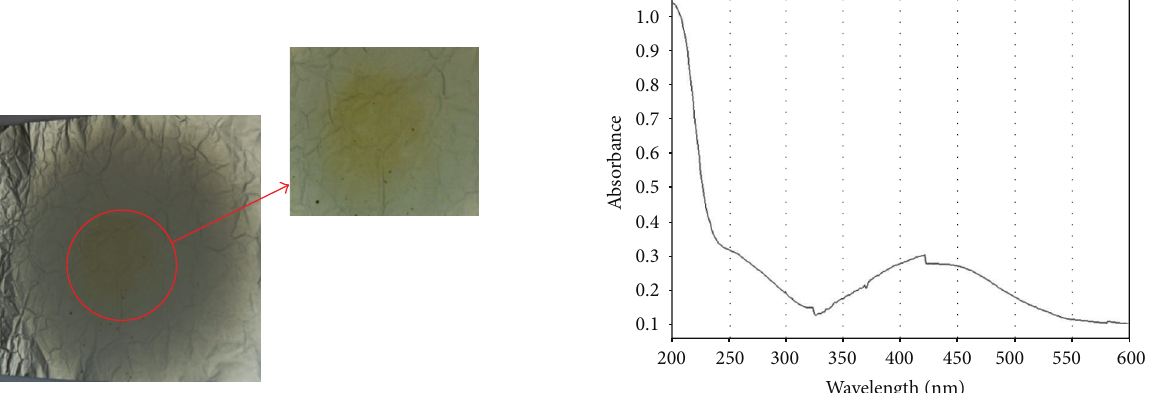
Figure 9: UV absorption spectrogram of water phase silver nanoparticle and PVA silver nanoparticle.